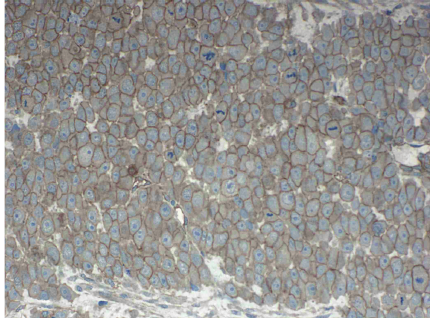
Figure 3: Histologic section of an osteosarcoma stained by a “cocktail” of antibodies against P-glycoprotein (MDR). In this case, the stain shows intense membranous accentuation with a sparse cytoplasmic reaction (MDR score = 3; original magnification